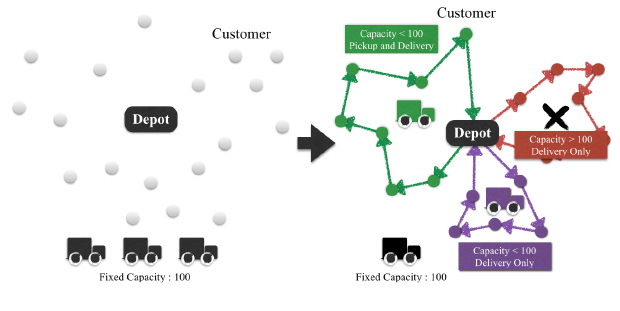
Figure 1. Concept of